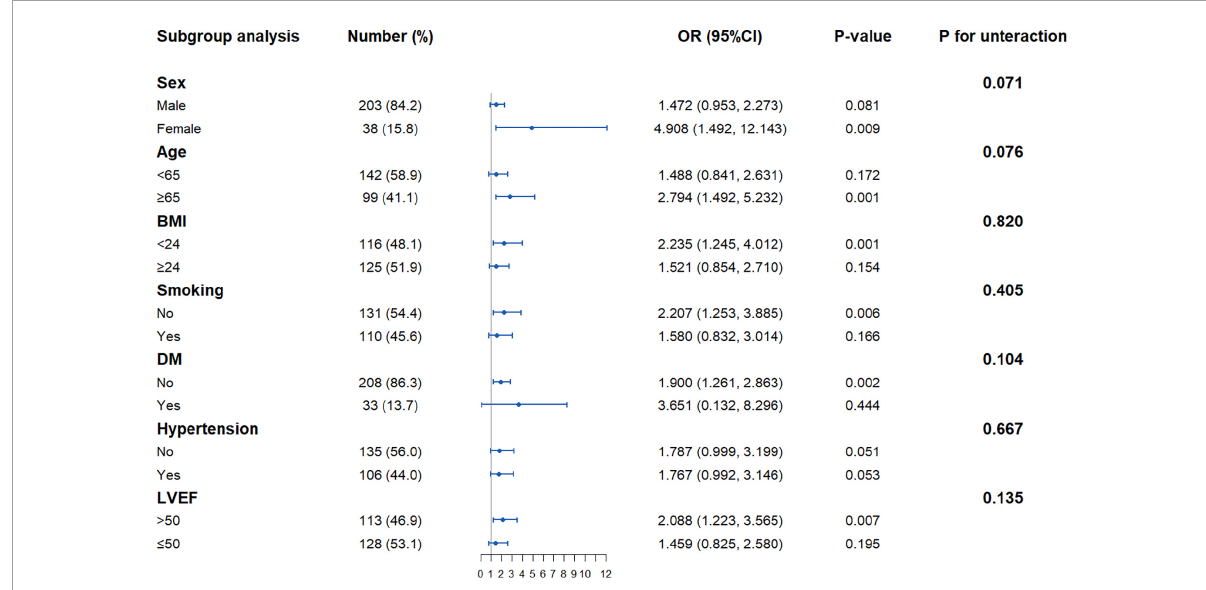
FIGURE2 Forest plot investigating the association between the TyG index and with the risk of post-PCI QFR ≤ 0.92 in different subgroups. TyG, triglyceride-glucose; QFR, quantitative flow ratio; BMI, body mass index; LVEF, left ventricular ejection fraction; DM, diabetes mellitus; PCI, percutaneous coronary intervention; OR, odds ratio; CI, confidence